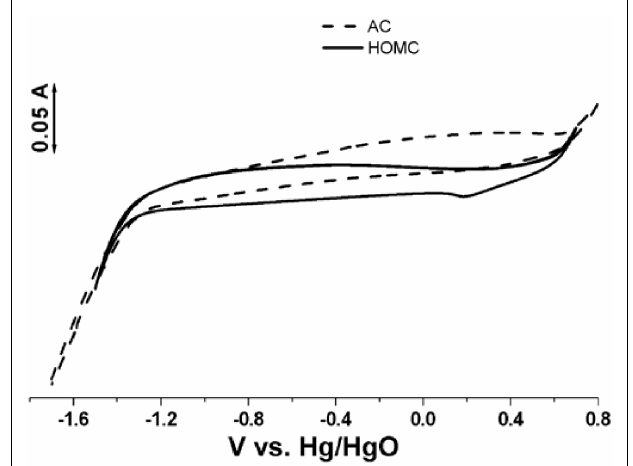
FIGURE 4 | Cyclic voltammograms of the HOMC (solid) andAC (dash) electrode recorded in a three electrode cell at 20mVs − 1 with 30% KOH aqueous solution . Pt mesh is used as counter electrode. Hg/HgO as reference